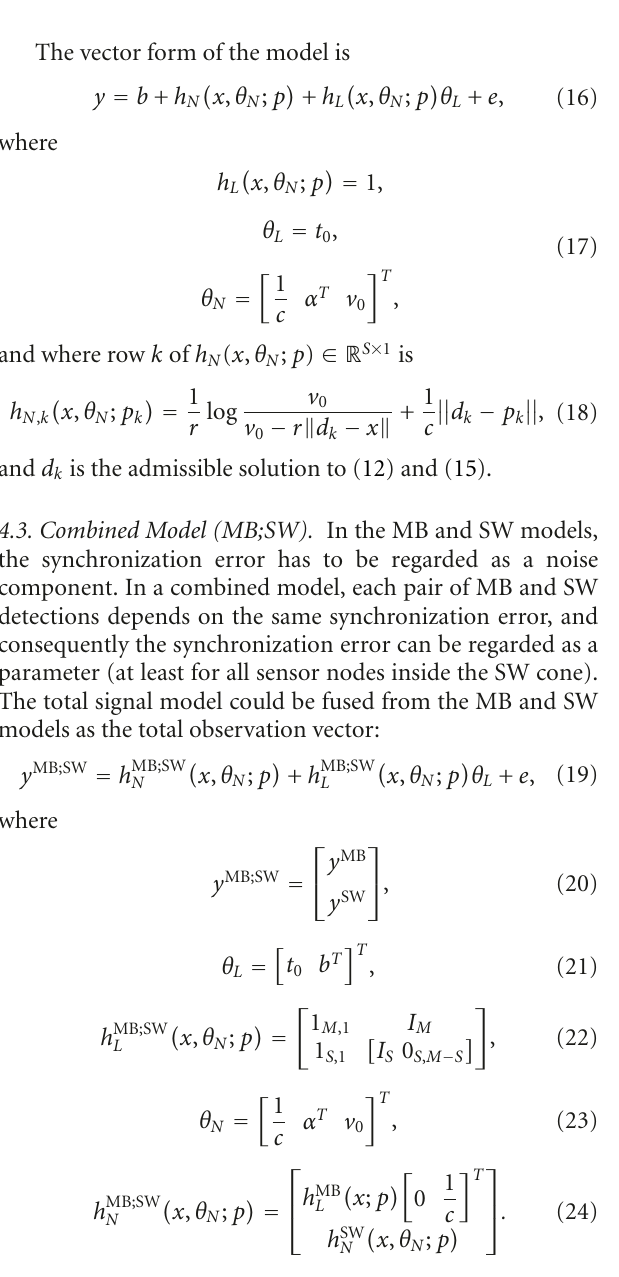
Figure 3: Geometry of supersonic bullet trajectory and shock wave. Given the shooter location x , the shooting direction (aim) α , the bullet speed v , and the speed of sound c , the time it takes from firing the gun to detecting the shock wave can be